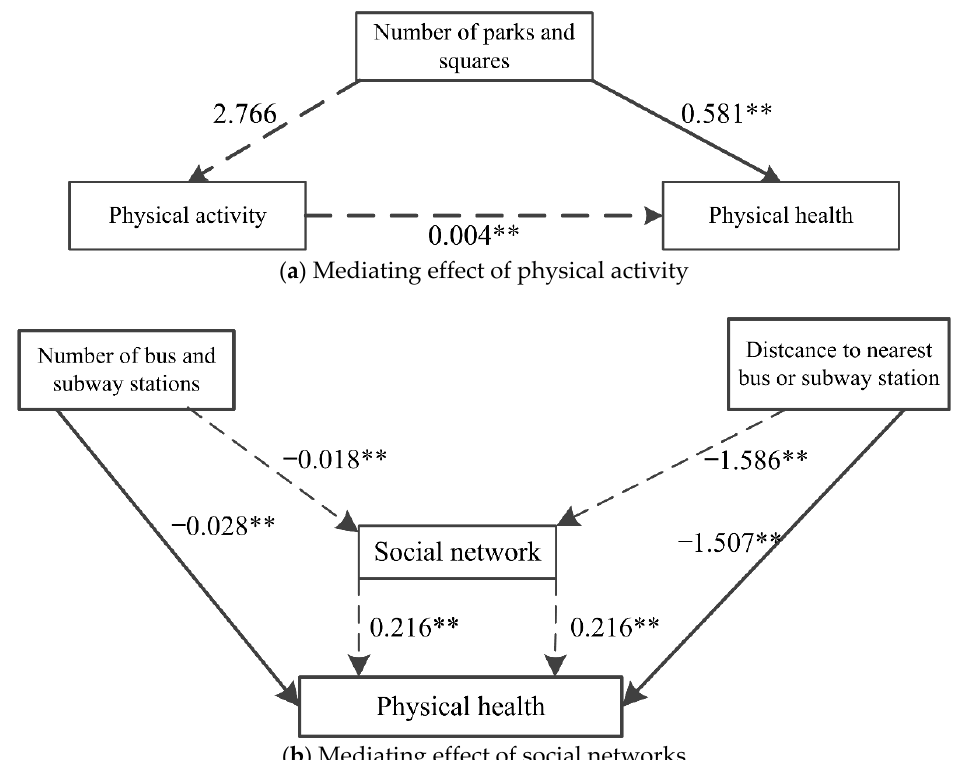
Figure 4. Path of mediating effect. Note: ** represents significant at 5% threshold level.